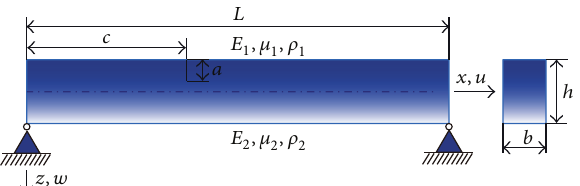
Figure 1: A FGM beam with a single open edge crack.